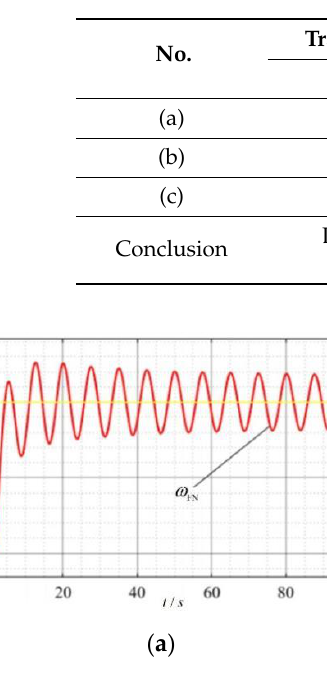
Figure 19. The output speed curve of the system for a variable F f ( s ) : ( a ) two-mass drivetrain system vibration waveform; ( b ) generator speed curve. The yellow line is the reference value line.